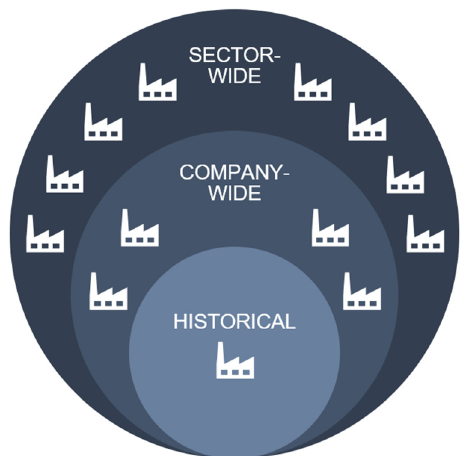
Figure 5. Different types of benchmarking with a broadening horizon.